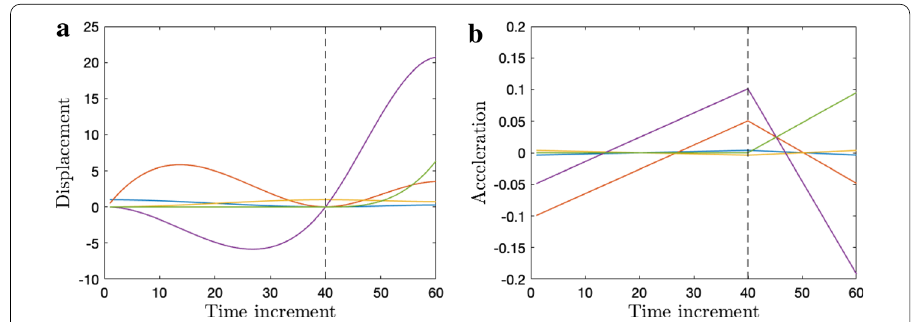
Fig. 11 Cubic splines ( a ) and 2nd order derivatives ( b ) for 2 elements (temporal node at time increments 0, 40 and 60) when continuities in terms of displacement, velocity and acceleration are prescribed. These results